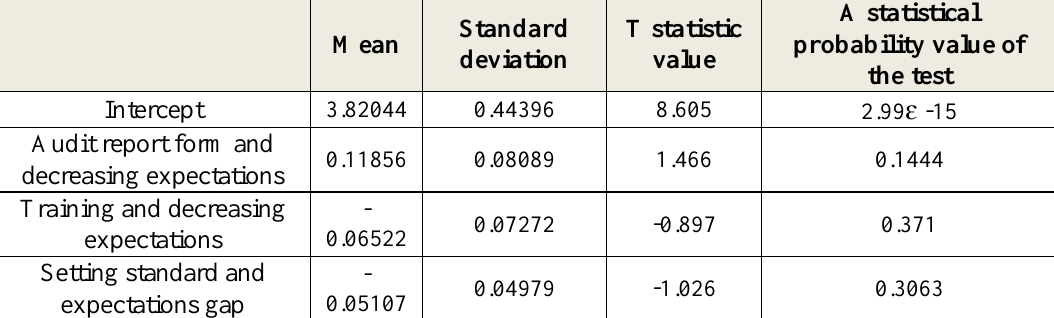
Table 13. Regression analysis of various factors in reducing audit expectation gap and